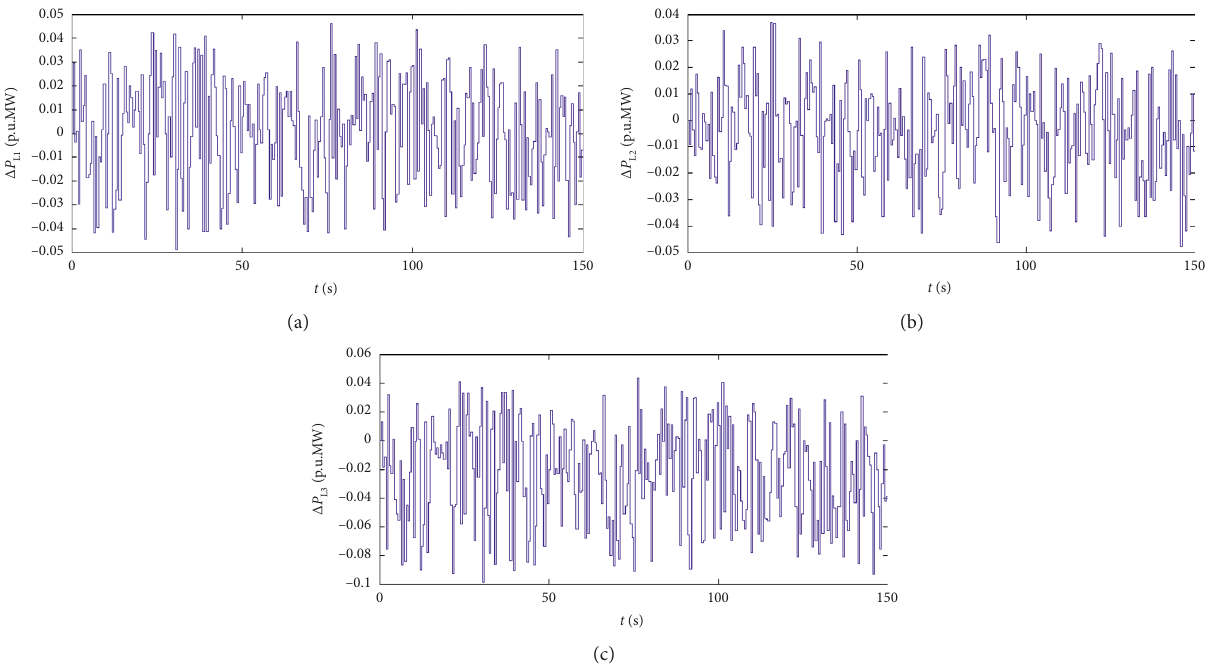
Figure 9: Random input signals. (a) Random input signal Δ P L1 . (b) Random input signal Δ P L2 . (c) Random input signal Δ P L3